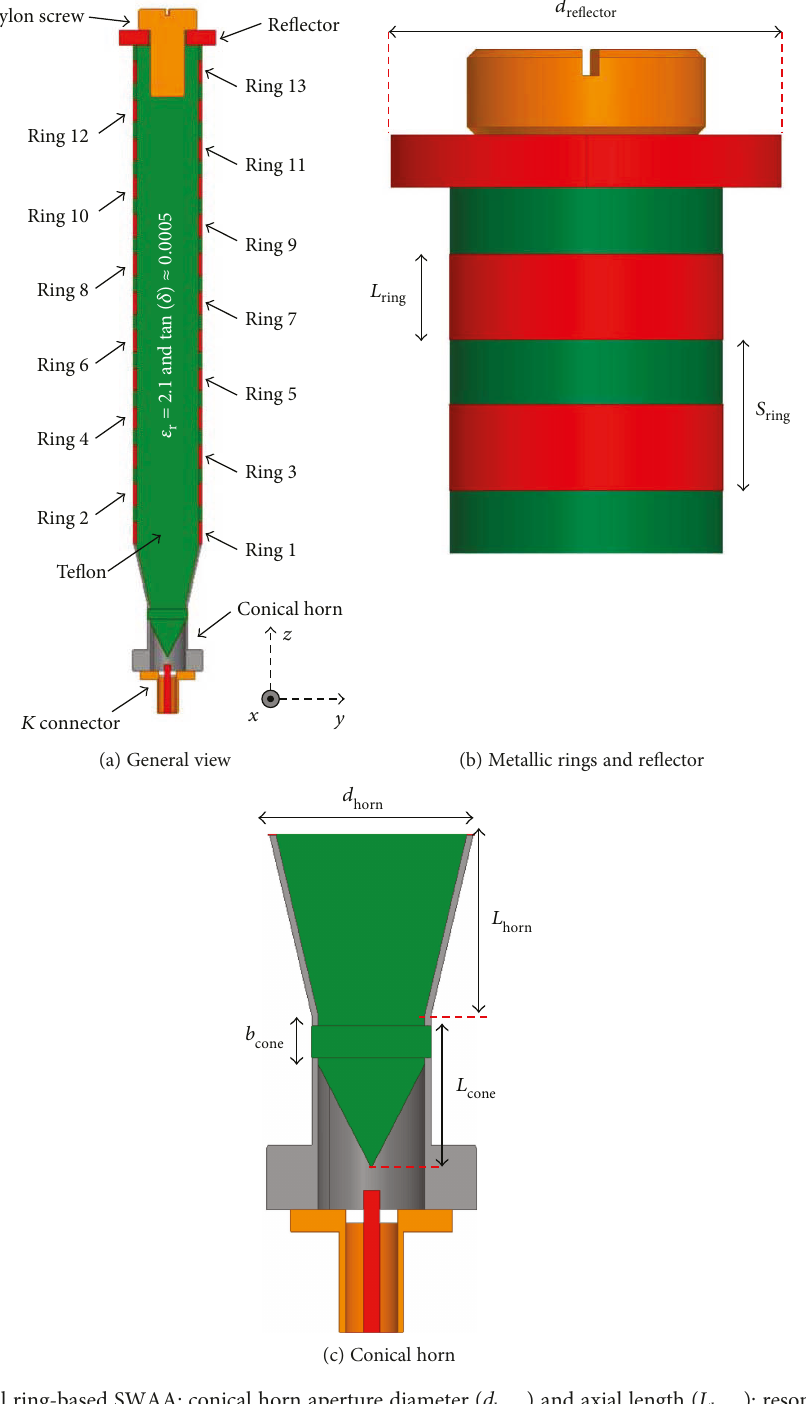
) and axial length ( L horn ) and length ( L ); re fl ector diameter ( d cone cone re fl ector